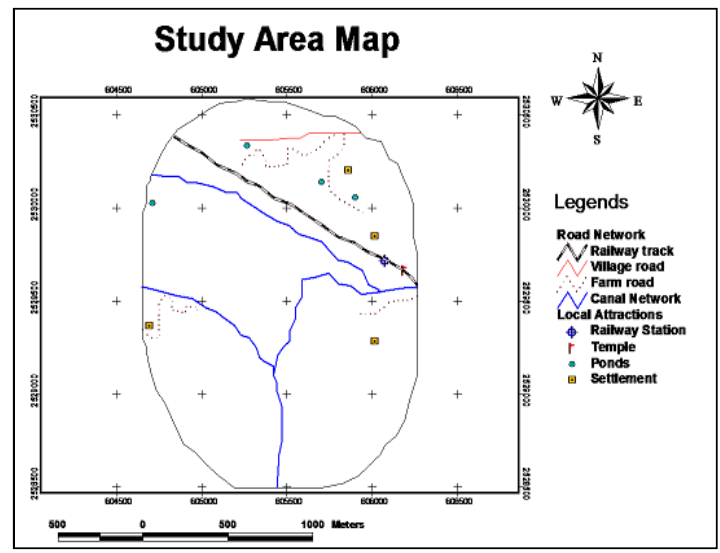
Figure 2. Study area map.